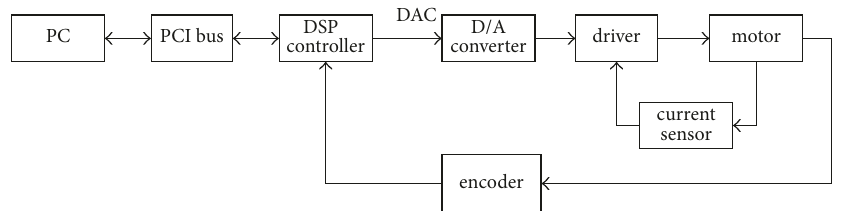
Figure 1: The structure of the servo system.